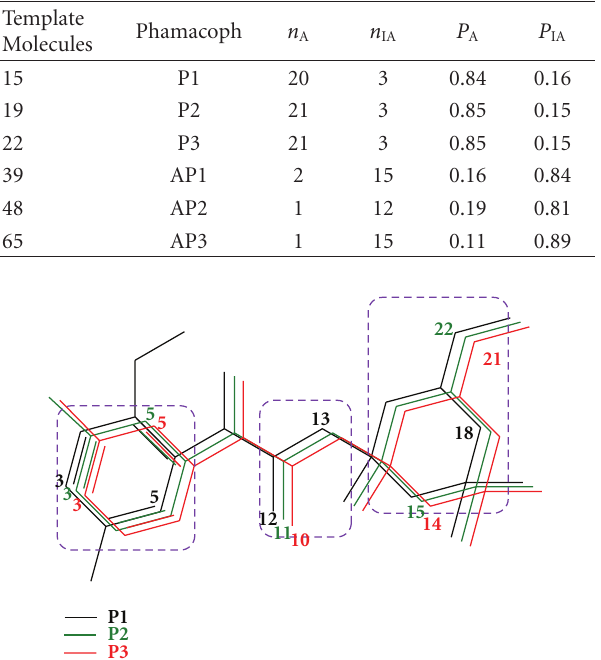
Figure 4: Template compounds 15 , 19 and 22 alignment by superposing the P1, P2, and P3 features.